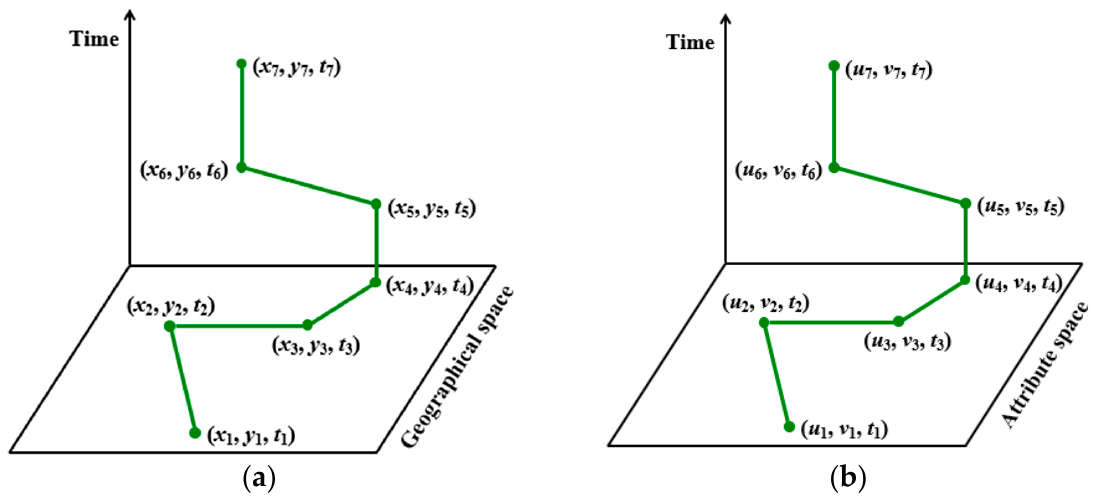
Figure 2. Illustration of traditional trajectory and attribute trajectory: ( a ) a traditional trajectory, and ( b ) a novel attribute trajectory.